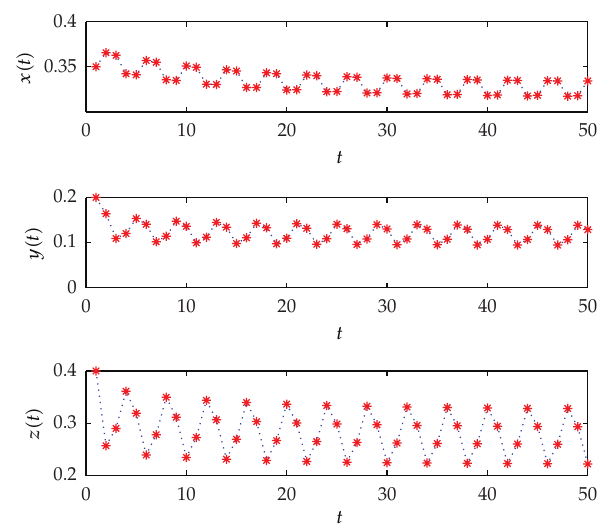
Figure 2: T (cid:9) Z , m (cid:9) 0 . 6. Dynamics behavior of system (cid:6) 4.1 (cid:7) with initial condition x (cid:6) 0 (cid:7) (cid:9) 0 . 35, y (cid:6) 0 (cid:7) (cid:9) 0 . 2, z (cid:6) 0 (cid:7) (cid:9) 0 . 4.